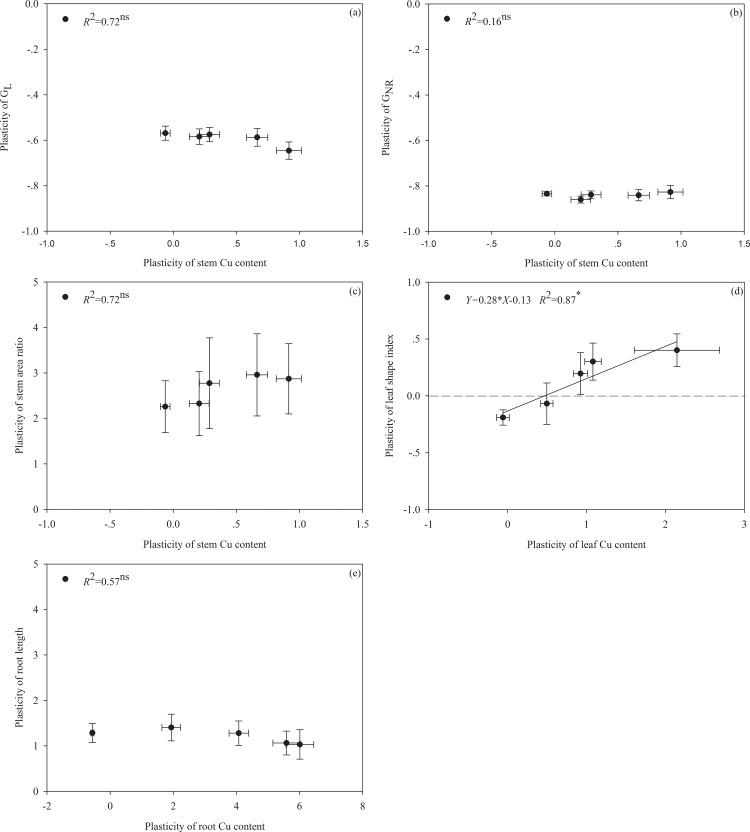
Relationship between the plasticity of the mean stem Cu content of the plants throughout the entire experiment and the plasticity of the mean growth rate of the total length (GL) (a), mean growth rate of new ramets (GNR) (b), stem area ratio (c), leaf shape index (d) and root length (e);between the plasticity of the mean leaf Cu content and the plasticity of the leaf shape index; and between the plasticity of the mean root Cu content and the plasticity of root length. Regression equations (unbroken line), coefficient of determination (R2) and significance level (*, P< 0.05; ns, P> 0.05) are indicated. The broken line represents the expected relationship when there is no plasticity in the trait depicted on the y axis.